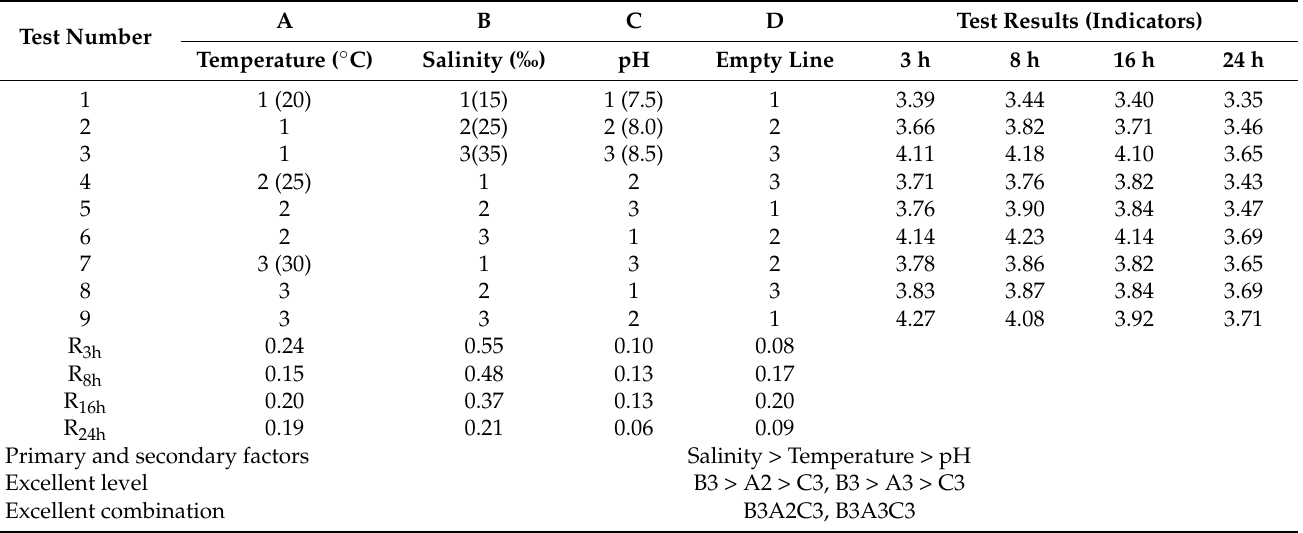
Figure 4. Concentration of eDNA in different treatment groups of yellowfin seabream. The bars represent the mean values of eDNA concentrations, and different colours represent different times. Table 4. Analysis of the range of results from the orthogonal experiment (3–24 h).